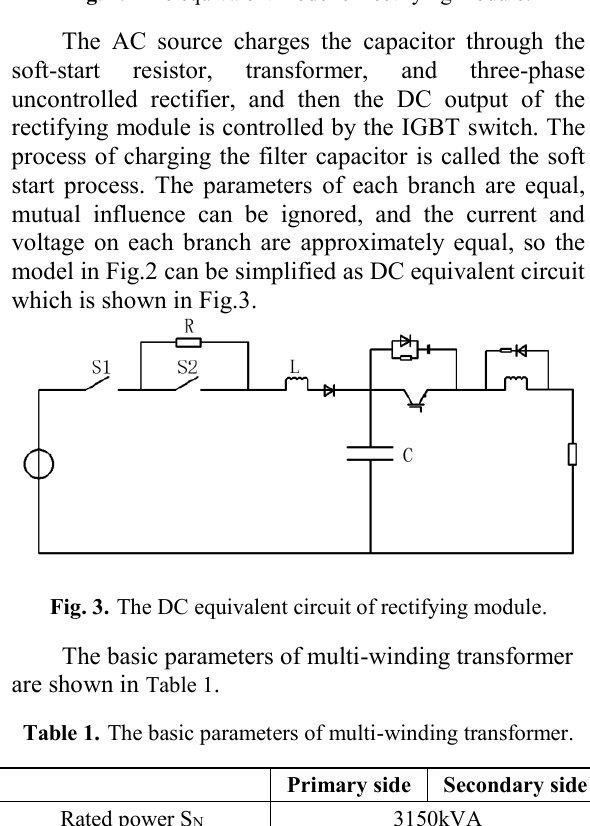
Fig. 2. The equivalent model of rectifying module.